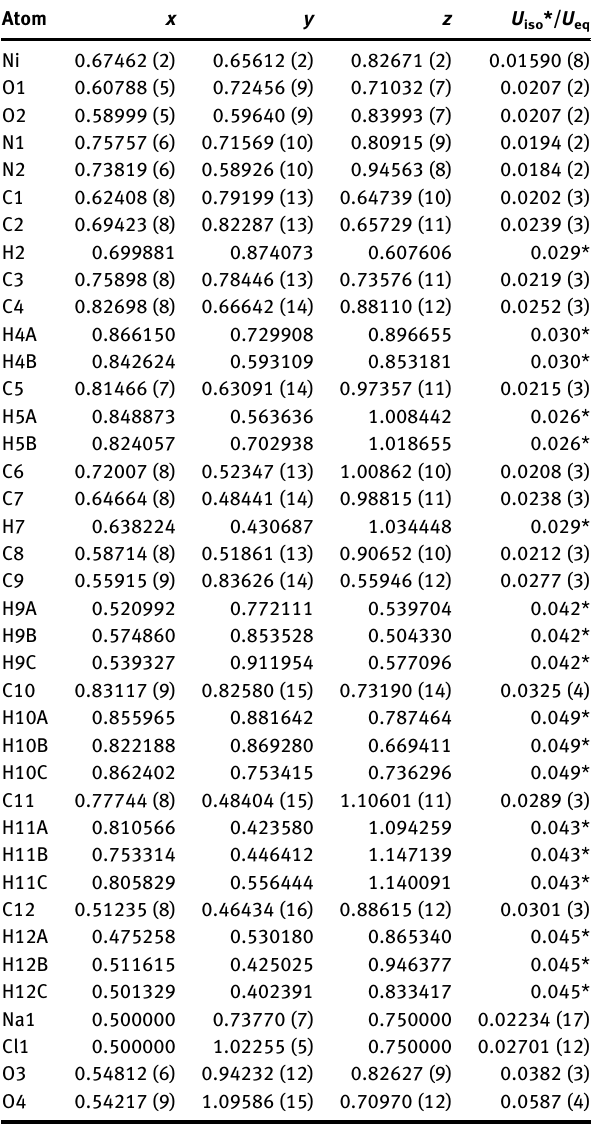
Table  : Fractional atomic coordinates and isotropic or equivalent isotropic displacement parameters (Å 